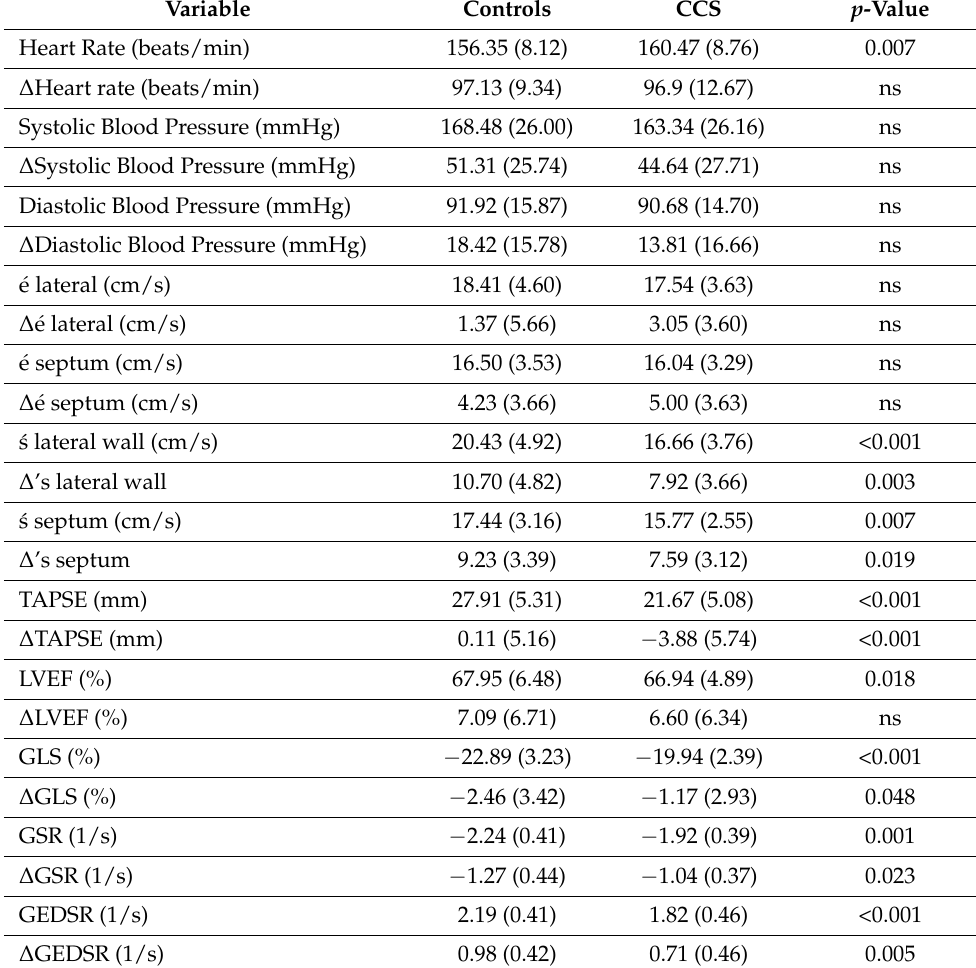
Table 5. Cardiac measures during DSE at high dobutamine